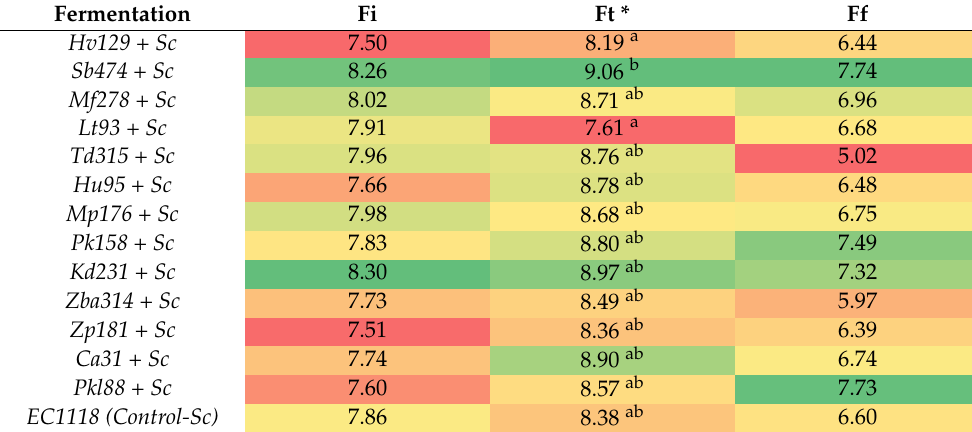
Table 2. Heat map of the number of viable yeasts at different stages of sequential fermentation with non- Saccharomyces yeasts + S. cerevisiae EC1118 (Sc) expressed as log of colony forming units per milliliter (Log CFU/mL). The darkest green indicates the highest number of yeasts, and red indicates the lowest.